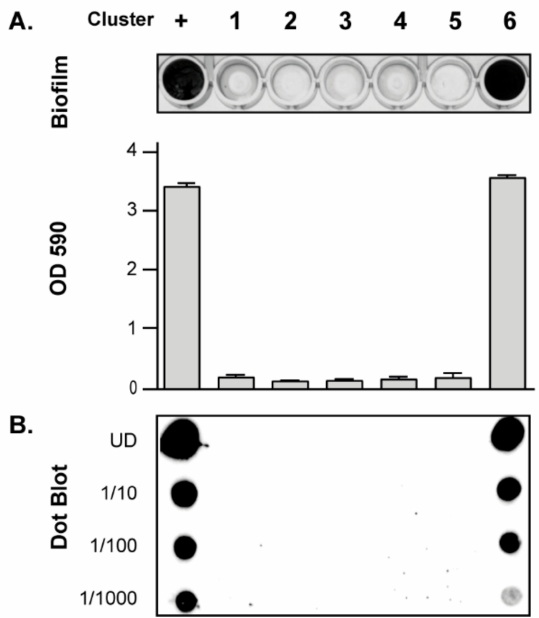
Figure 3. Biofilm formation capacity and PIA/PNAG production analyses of one representative S. aureus PJI isolate of clusters one to six. Cluster 1: MIC 6935; cluster 2: MIC 6924; cluster 3: MIC 6934; cluster 4: MIC 6936; cluster 5: MIC 6948; cluster 6: MIC 7018. ( A ) Biofilm phenotype on polystyrene microtiter plates after 24 h of growth at 37 ◦ C in TSB-NaCl medium. Bacterial cells were stained with crystal violet, and biofilms were quantified by solubilizing the crystal violet with alcohol-acetone and determining the absorbance at 590 nm . The error bars represent the standard deviations of the results of three independent experiments. ( B ) Quantification of PIA/PNAG exopolysaccharide biosynthesis by dot-blot. Samples were analyzed after 16 h of static incubation in TSB-NaCl at 37 ◦ C. Serial dilutions (1/10) of the samples were spotted onto nitrocellulose membranes and PIA/PNAG production was detected with specific anti-PIA/PNAG antibodies. UD; undiluted sample. +; a strong PIA/PNAG dependent biofilm forming strain was included as a